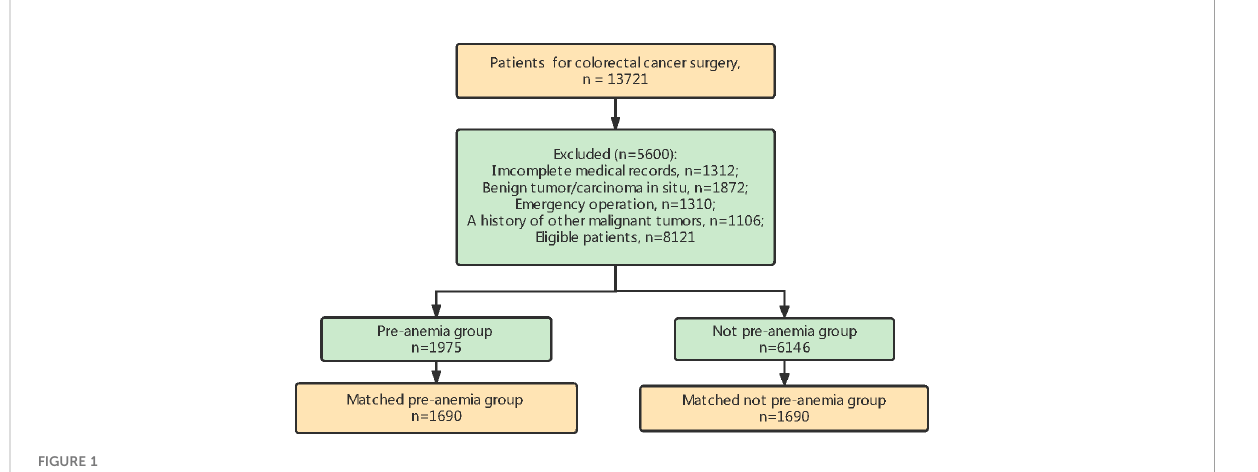
FIGURE 1 Flow chart of patient